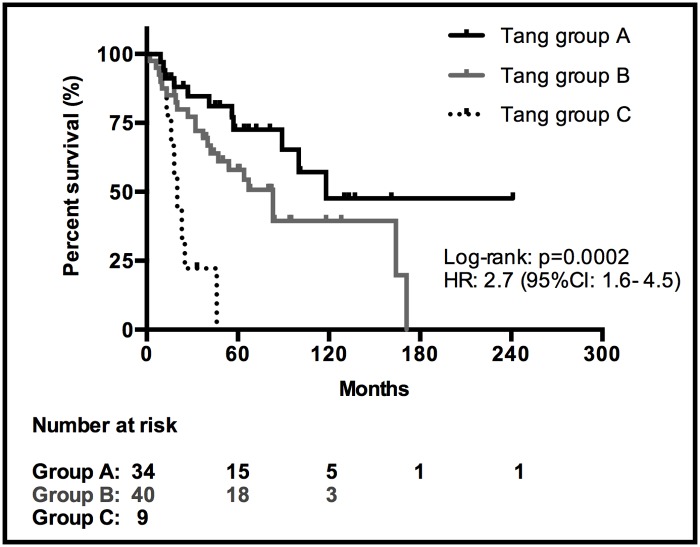
Kaplan-Meier survival curves of the Tang classification.